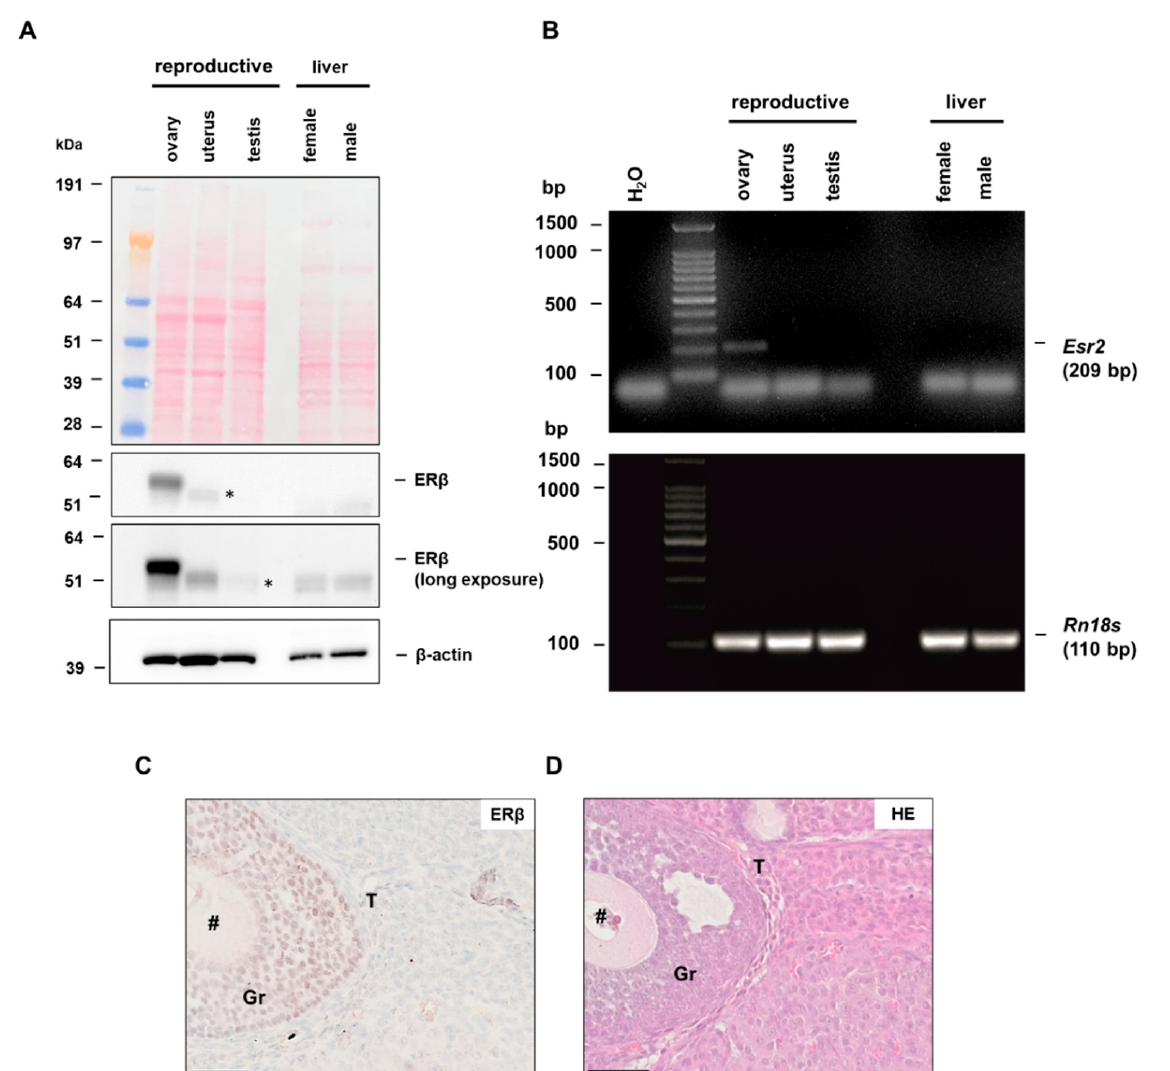
Figure 1. Estrogen receptor beta (ER β ) expression in different tissues. Murine tissues were collected and processed for protein or mRNA analysis as described in Material and Methods: ( A ) ER β protein expression was analyzed by western blot analysis in ovarian, uterine, testis and liver tissue extracts with monoclonal antibody PPZ0506. Ponceau S stain confirms successful transfer and β -actin re-probing served as an internal loading control. ER β protein could only be detected in the murine ovary. Asterisks (*) indicate non-specific bands: ( B ) in line, the 206 bp Esr2 amplicon amplified by RT-PCR in ovarian tissue was absent in all other analyzed tissues. The product of Rn18s (110 bp) served as a control; ( C ) immunohistochemical staining for ER β using PPZ0506 in optimized conditions show strong ER β -positive granulosa cells (Gr). Further cell types indicated are: #, oocyte cell, T, theca cells; and ( D ) routine HE staining of murine ovary showed the general histology of the tissue. Scale bar 50 µm (400×).